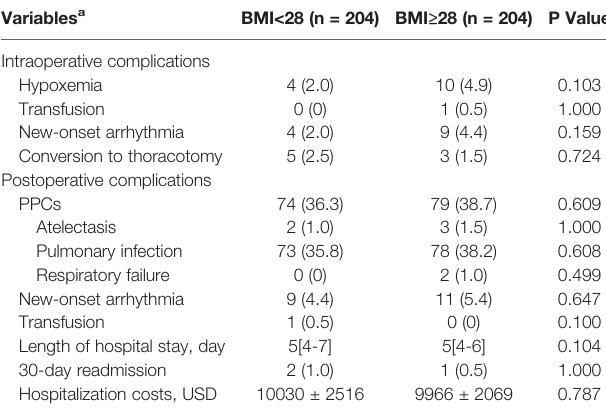
TABLE 6 | Intra- and postoperative complications strati fi ed by BMI after a 1:1 PSM. Variables